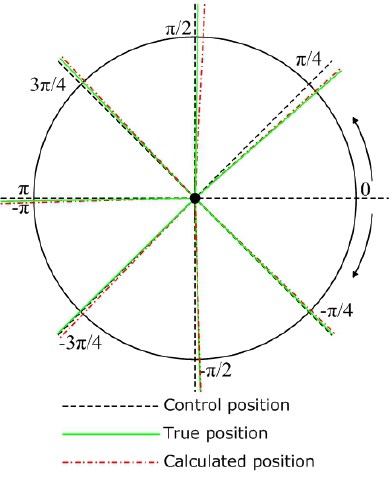
Figure 9. Cumulative errors in localization when the node performs in-situ turning.